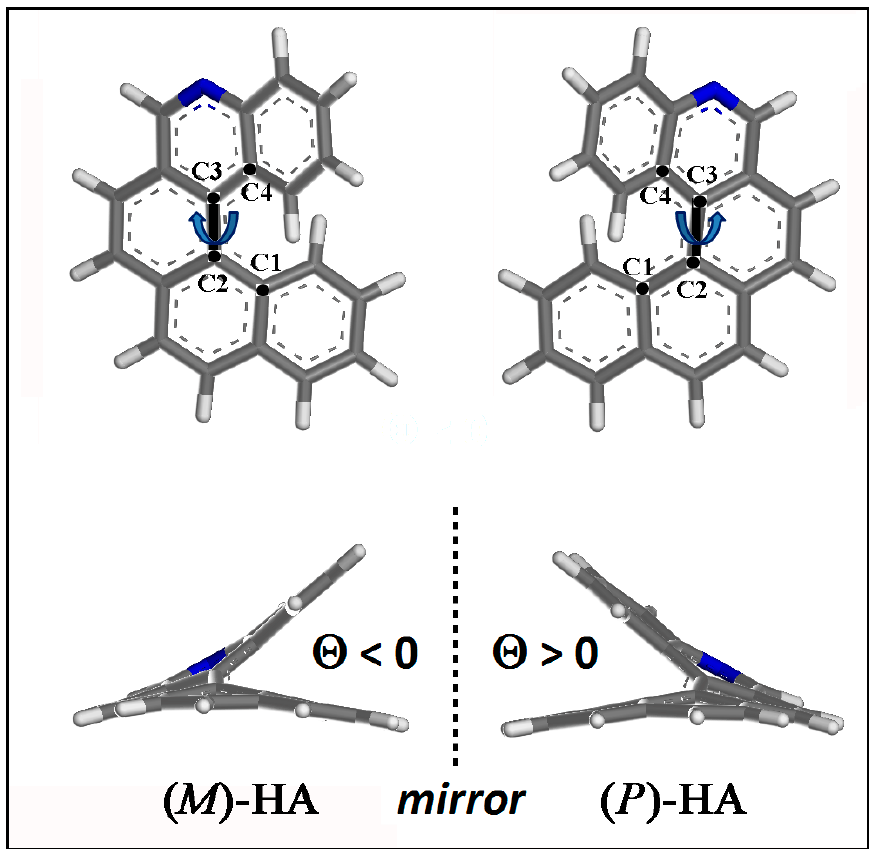
Figure 3. Optimized geometries of ( M )-5-Aza[5]helicene and ( P )-5-Aza[5]helicene. Color code: Carbon atoms are grey, the nitrogen blue and the hydrogens are white. The four carbon atoms C1, C2, C3 and C4, which describe the dihedral angles Θ for the two enantiomers, are shown.